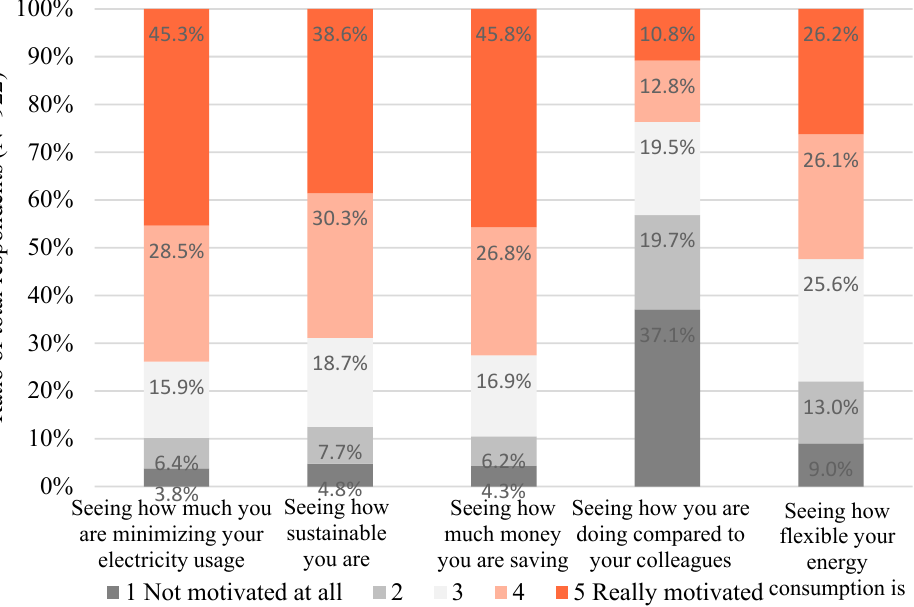
Figure 10. List of motivating information to accept flexible energy usage.